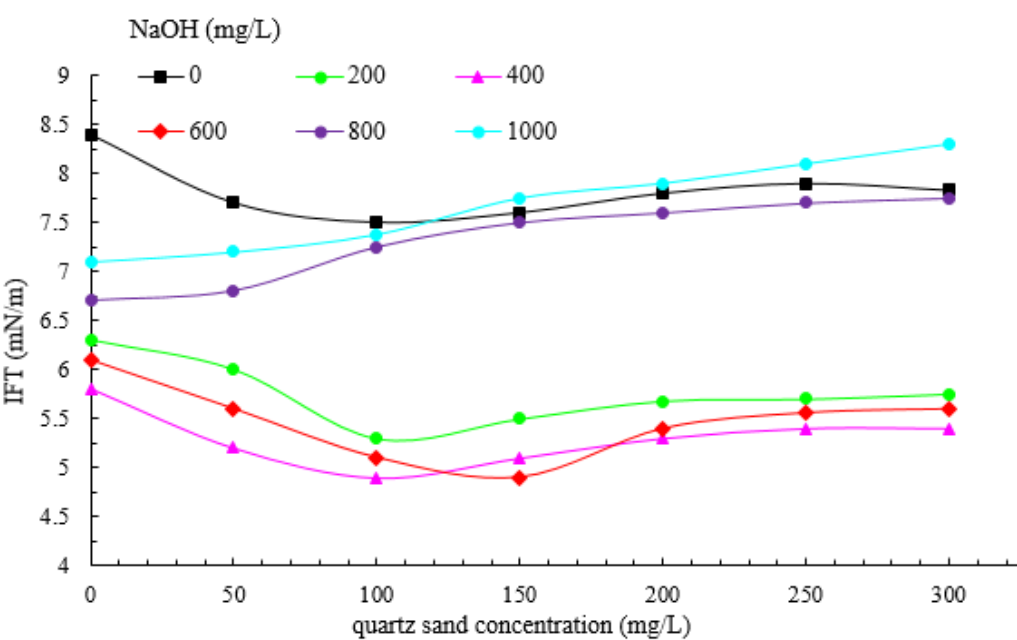
Figure 9. The synergetic effect of quartz sand particles and alkali on interfacial tension (polymer concentration 500 mg/L, surfactant concentration 200 mg/L).